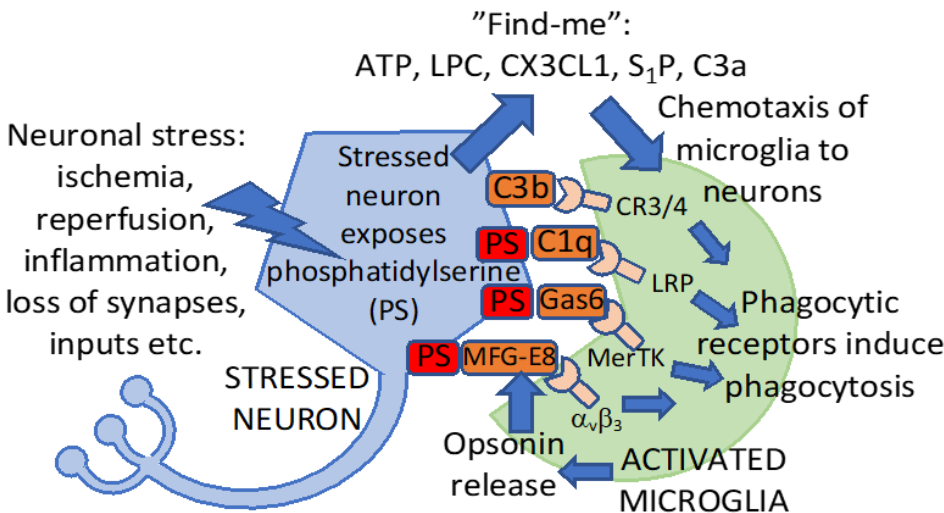
Figure 2. Signaling between neurons and microglia inducing phagocytosis. After a stroke, neurons may be stressed by ongoing ischemia, oxidants, inflammation, excitotoxins or the loss of synapses. Neuronal stress can induce the release of “find-me” signals and exposure of the “eat-me” signal phosphatidylserine (PS, red), which binds opsonins (brown, released by activated microglia), which then bind phagocytic receptors on microglia to induce phagocytosis. ATP, adenosine triphosphate; LPC, lysophosphatidylcholine; CX3CL1, fractalkine; S1P, sphingosine-1-phosphate; C3a, C3b, C1q: complement components 3a, 3b and 1q; Gas6, growth arrest–specific 6; MFG-E8, milk fat globule-EGF factor 8 protein; MerTK, mer tyrosine kinase; integrin α v β 3, vitronectin receptor; LRP, low density lipoprotein receptor-related protein (a phagocytic receptor for C1q); CR3, complement receptor 3; and CR4, complement receptor 4. The activation of these receptors by their opsonins bound to neurons induces microglial phagocytosis of these neurons.